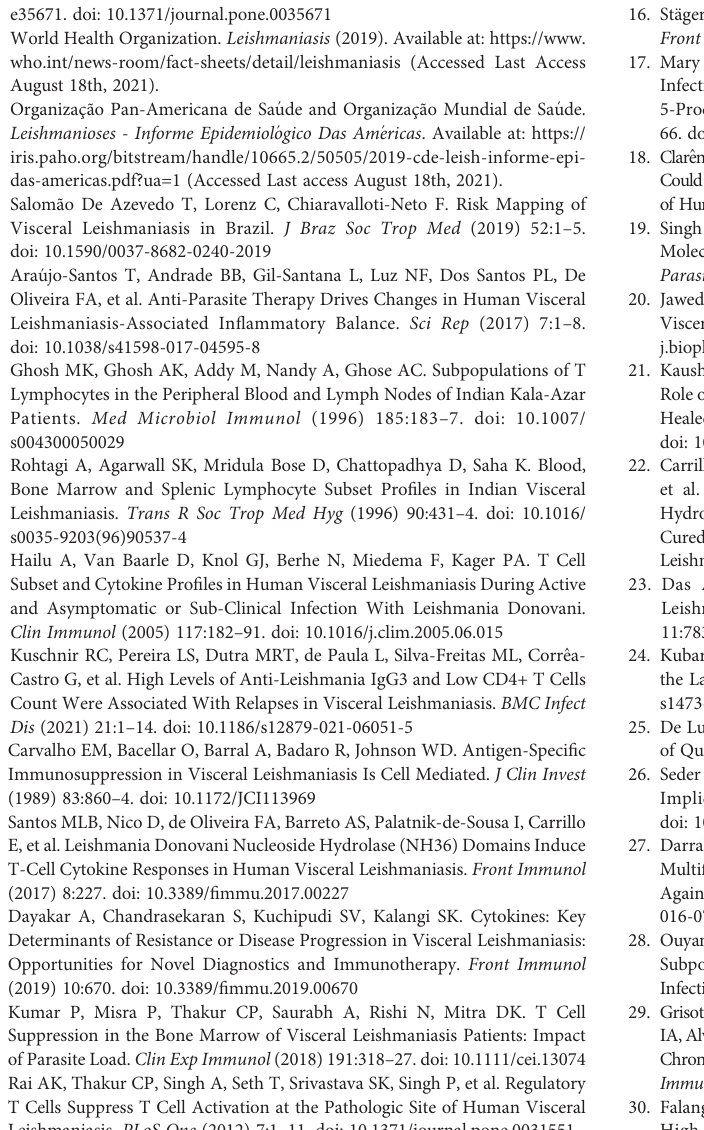
Supplementary Figure 5 | Evolution of the relative proportions of each CD8 + cytokine-expressing subtype considering separately the patients treated with LAMB orMA.Thegraphrepresents thevariation ofthe percentofeach typeofTcell among all cytokine-expressing CD8 + T cells along the